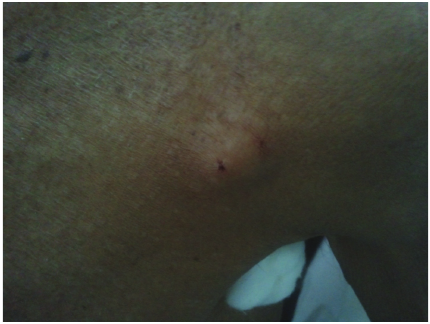
Figure 1: Swelling measuring 2 × 2 cm over the left shoulder. Swelling was hard and